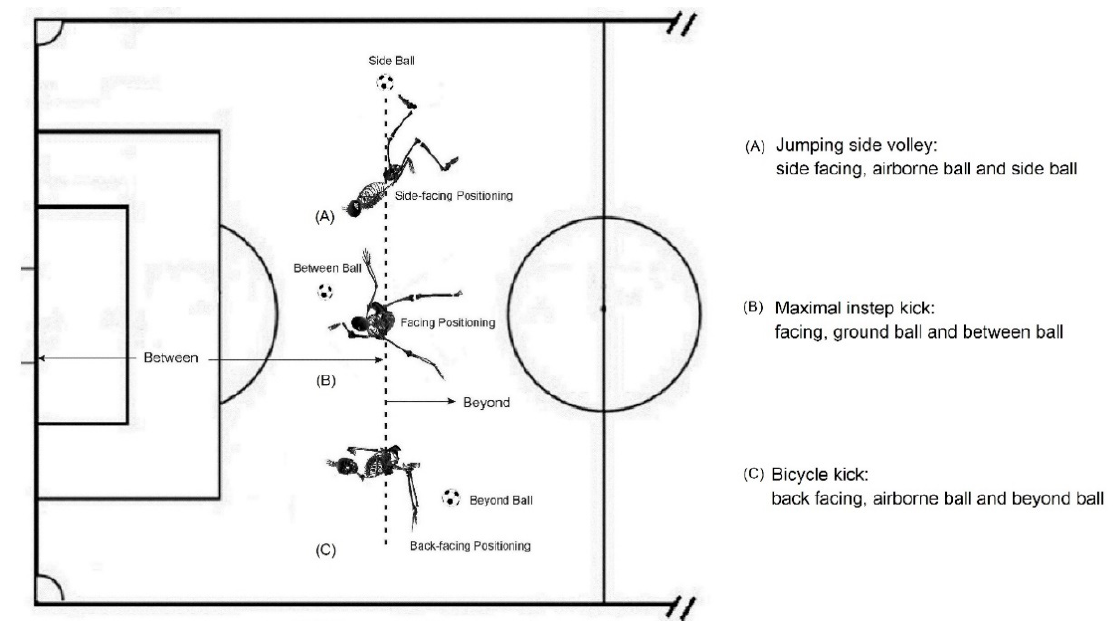
Figure 1. The identification and clarification of spatial factors. ( A ) The 3D quantification of a jumping side volley–top view [4,43]. ( B ) The 3D quantification of the maximal instep kick–top view [52–54]. ( C ) The 3D quantification of the bicycle kick–top view [9,43].